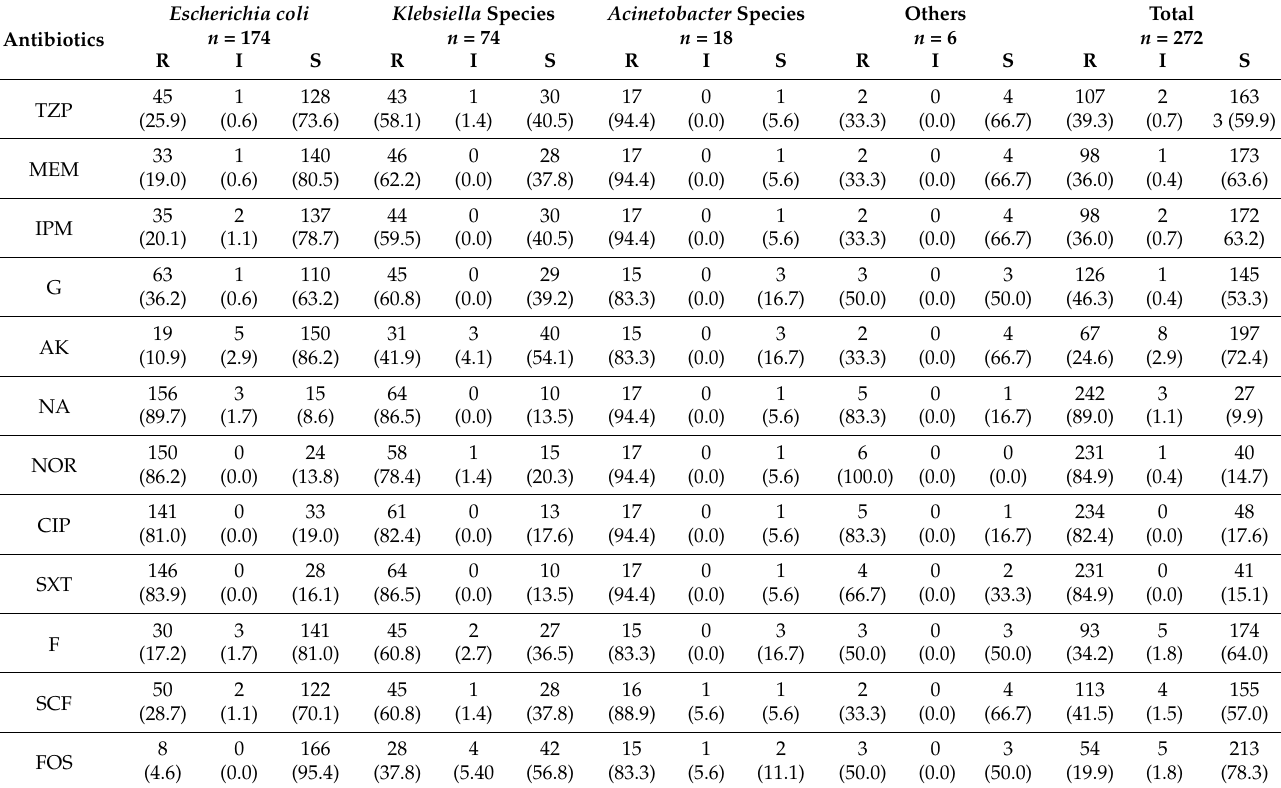
Table 2. Antimicrobial susceptibility testing against ESBL-producing Escherichia coli , Klebsiella species, Acinetobacter species and